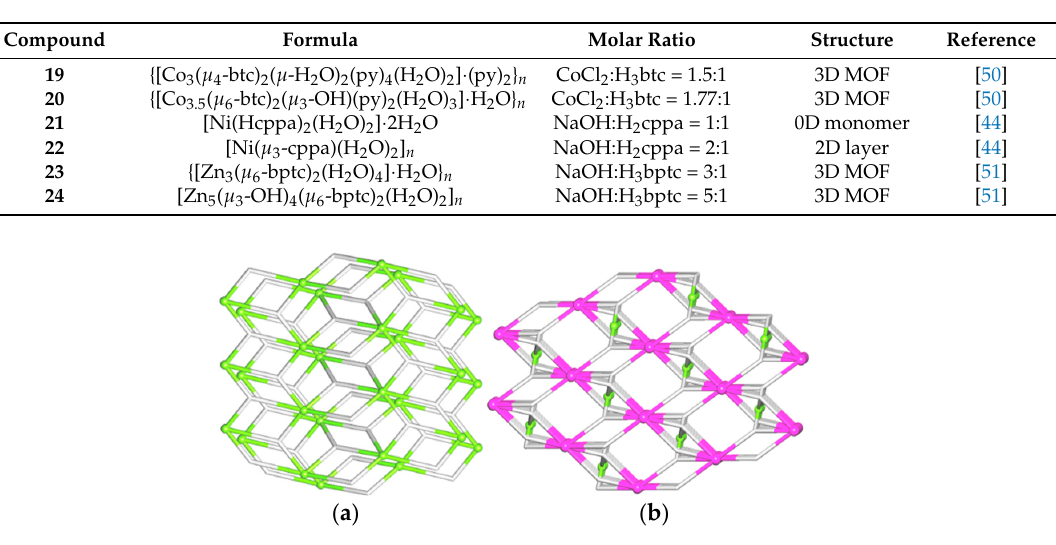
Figure 5. Topological representation of underlying 3D nets: ( a ) ant (anatase) net in 19 ; ( b ) topologically unique net in 20 with the point symbol of (4 2 .6) 4 (4 2 .8 4 )(4 6 .6 4 .8 14 .10 4 ). Adapted from [50].